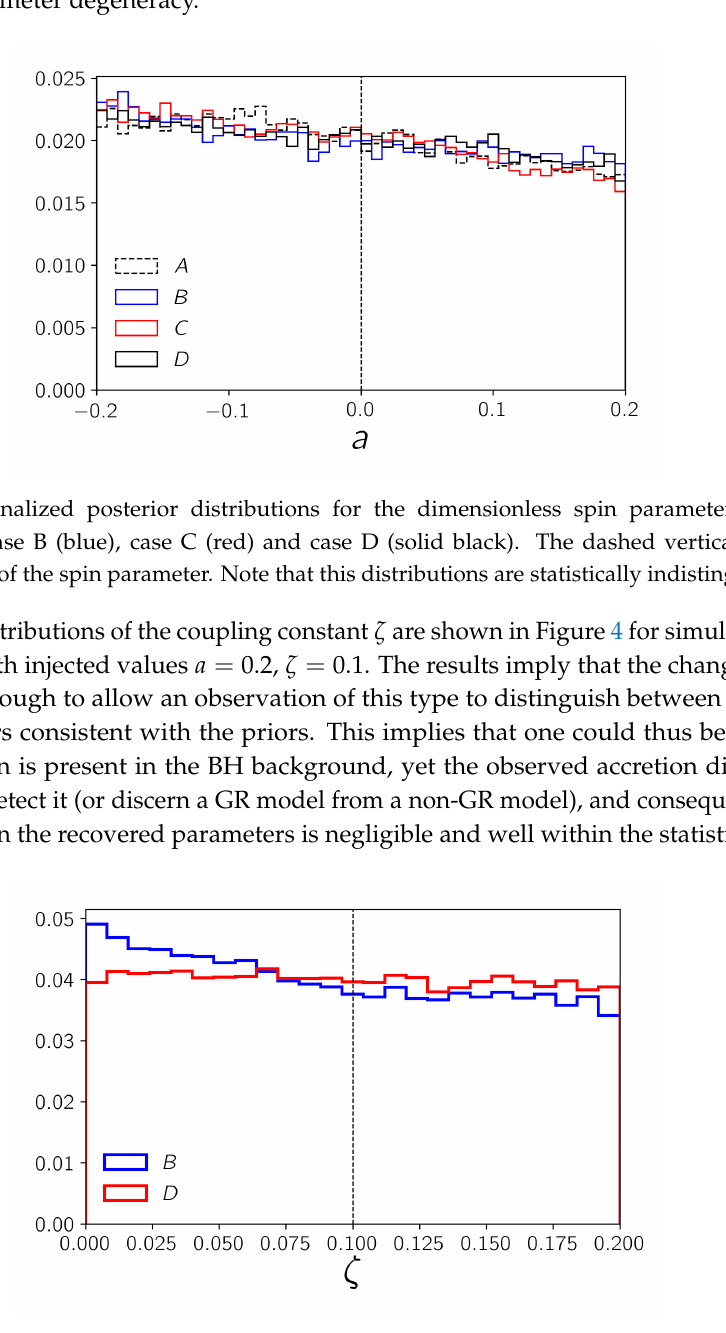
Figure 4. Marginalized posterior distributions for the dCS dimensionless coupling constant ζ for case B (blue) and case D (red), with an injected value of a = 0.2 for these simulations. The dashed vertical line shows the injected value for that parameter. Note that this distributions are statistically